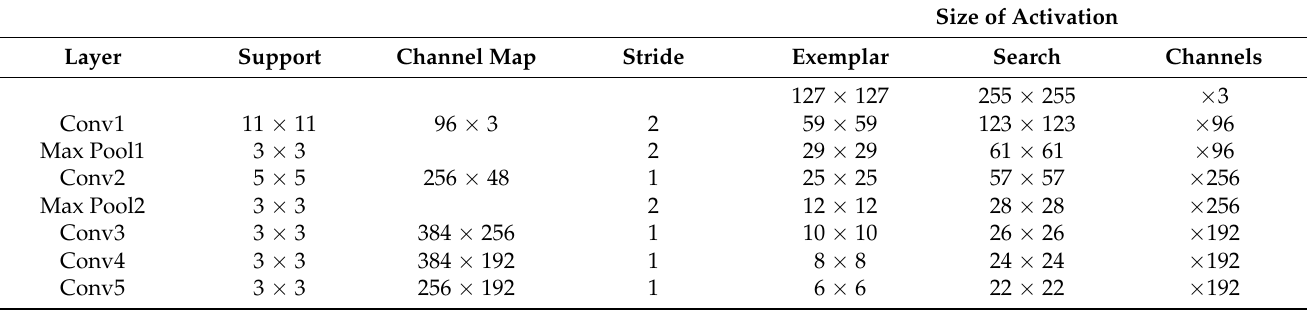
Table 1. Convolutional embedding function’s architecture of the network used in this work.